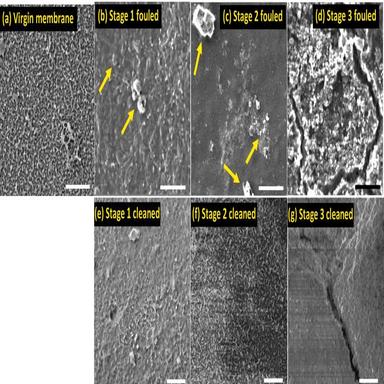
SEM images at 10,000X magnification for (a) virgin, (b–d) fouled, and (e–g) cleaned membranes. The arrows in (b) and (c) point to particles that were visible on fouled membranes. Images (e–g) correspond to membranes after chemical cleaning with STTP (discussed in Section. The scale bar corresponds to 5 μm in all cases.